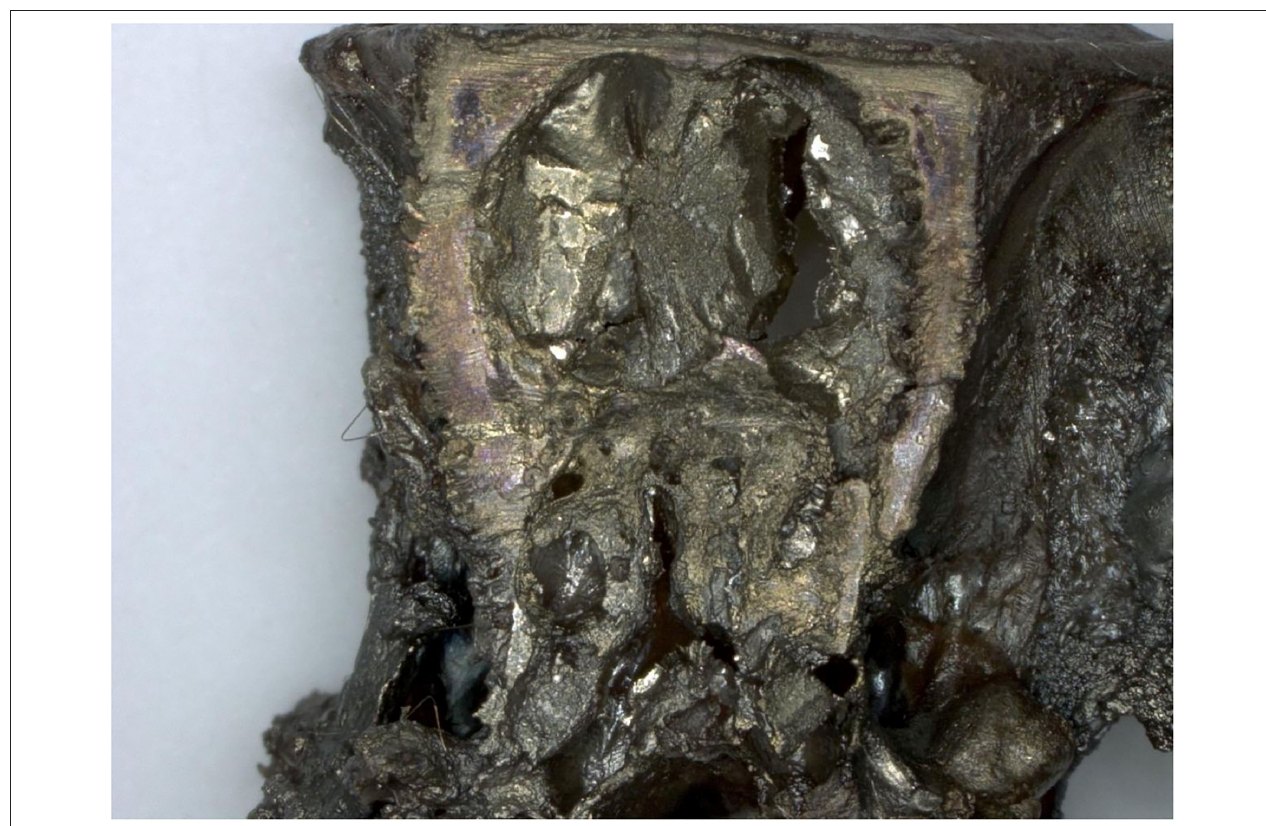
FIGURE 4 | Female rat. Deceased 1h. after transfer to cage. Nasal cavity level 4 (frozen, dried, sputtered sample): complete blockage by deposited test item. Digital microscopy, lens x30.